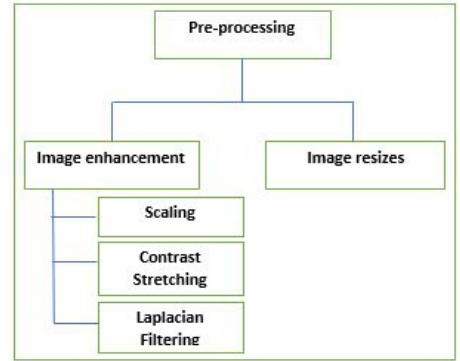
Figure 4. Framework of Proposed Pre-processing Techniques